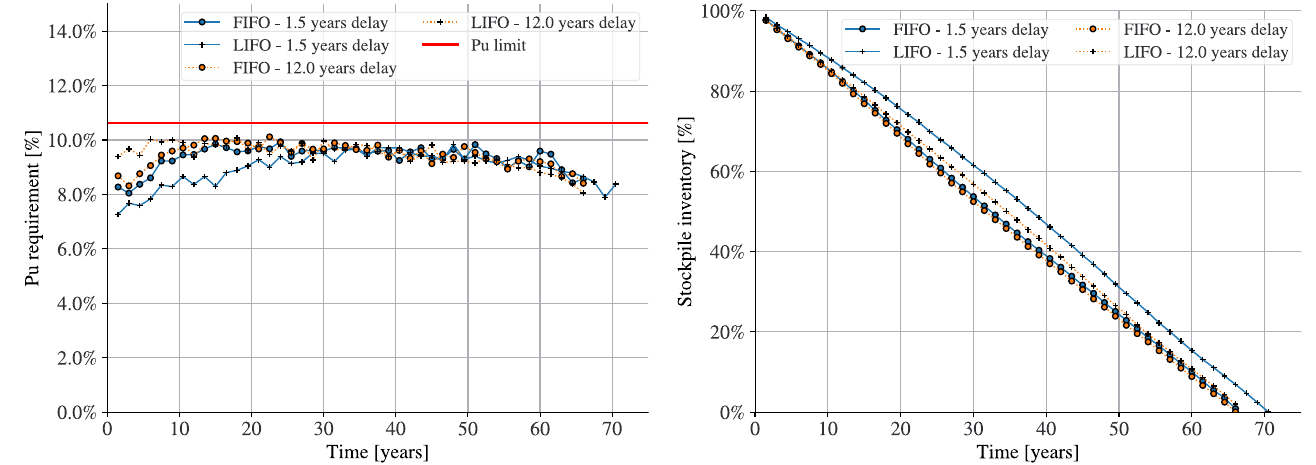
Fig. 8. The Pu fraction required to meet the energy equivalence for every reload cycle as a function of time passed since the reference date t 0 using the available irradiated UOX fuel coming out of the stockpile.